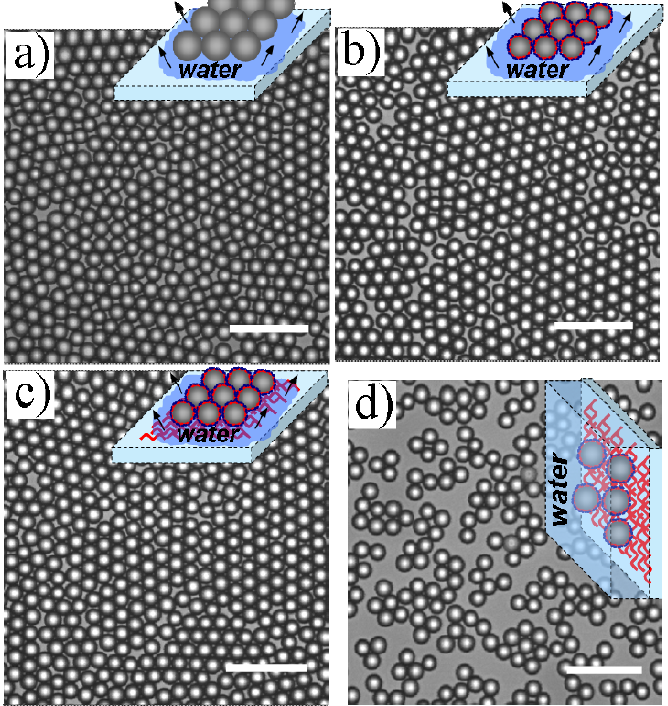
Figure 2. Confocal scanning laser microscope (CLSM) transmission microscopy images of evaporative self-assembly of ( a ) silica and ( b ) polyelectrolyte coated silica particles on cleaned glass substrates, and ( c ) polyelectrolyte coated silica particles on a PEI coated glass slide. ( d ) Adsorption of coated silica particles onto a PEI coated glass slide in an aqueous solution. The scale bars correspond to 20 